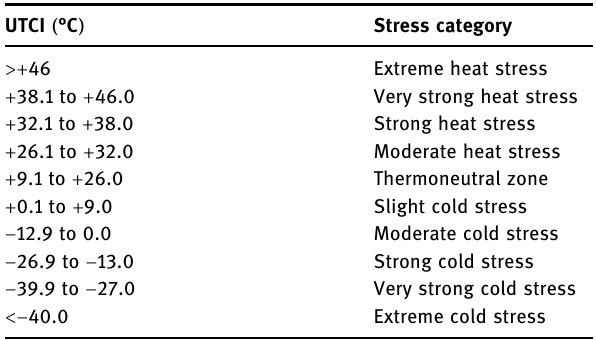
Table 1: The scale of assessment of heat stress of the human body [ 9